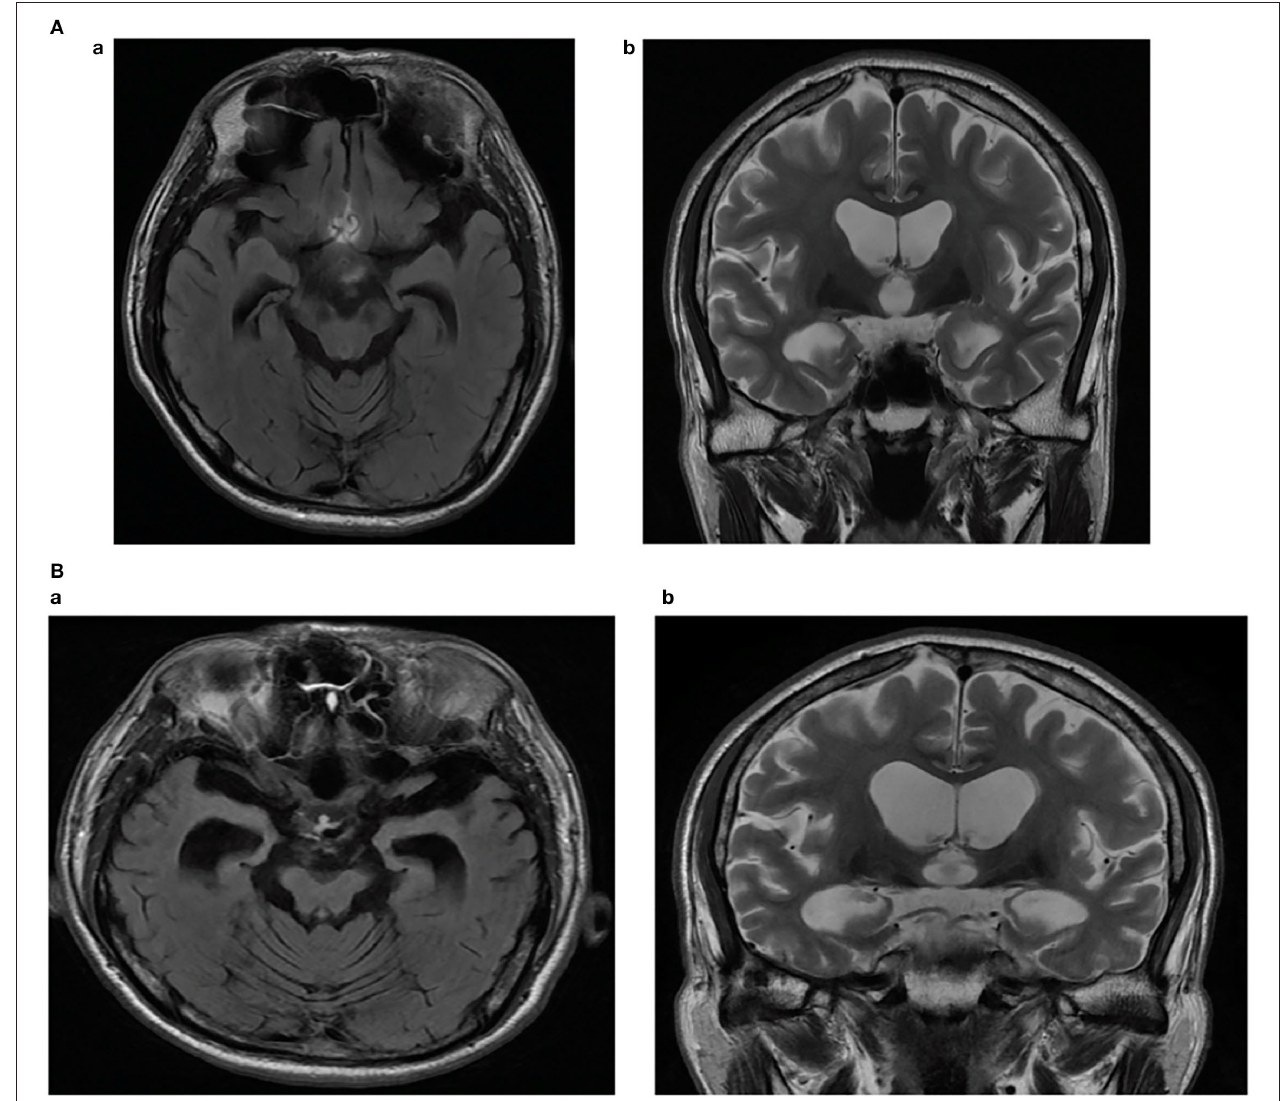
FIGURE 1 | (A) Brain magnetic resonance imaging of the patient showing diffuse atrophy of the brain, more predominant medial temporal lobes. Fluid-attenuated inversion recovery (FLAIR) axial image (a), T2-weighted coronal image (b). (B) Brain magnetic resonance imaging (MRI) of the patient showing interval progression of diffuse (mainly frontotemporal) brain atrophy and marked medial temporal lobar atrophy after 18 months. Marked increased in size of with signal void in cerebral aqueduct, decreased in size of both basal ganglia compared to the MRI of the first visit are revealed. Fluid-attenuated inversion recovery (FLAIR) axial image (a), T2-weighted coronal image